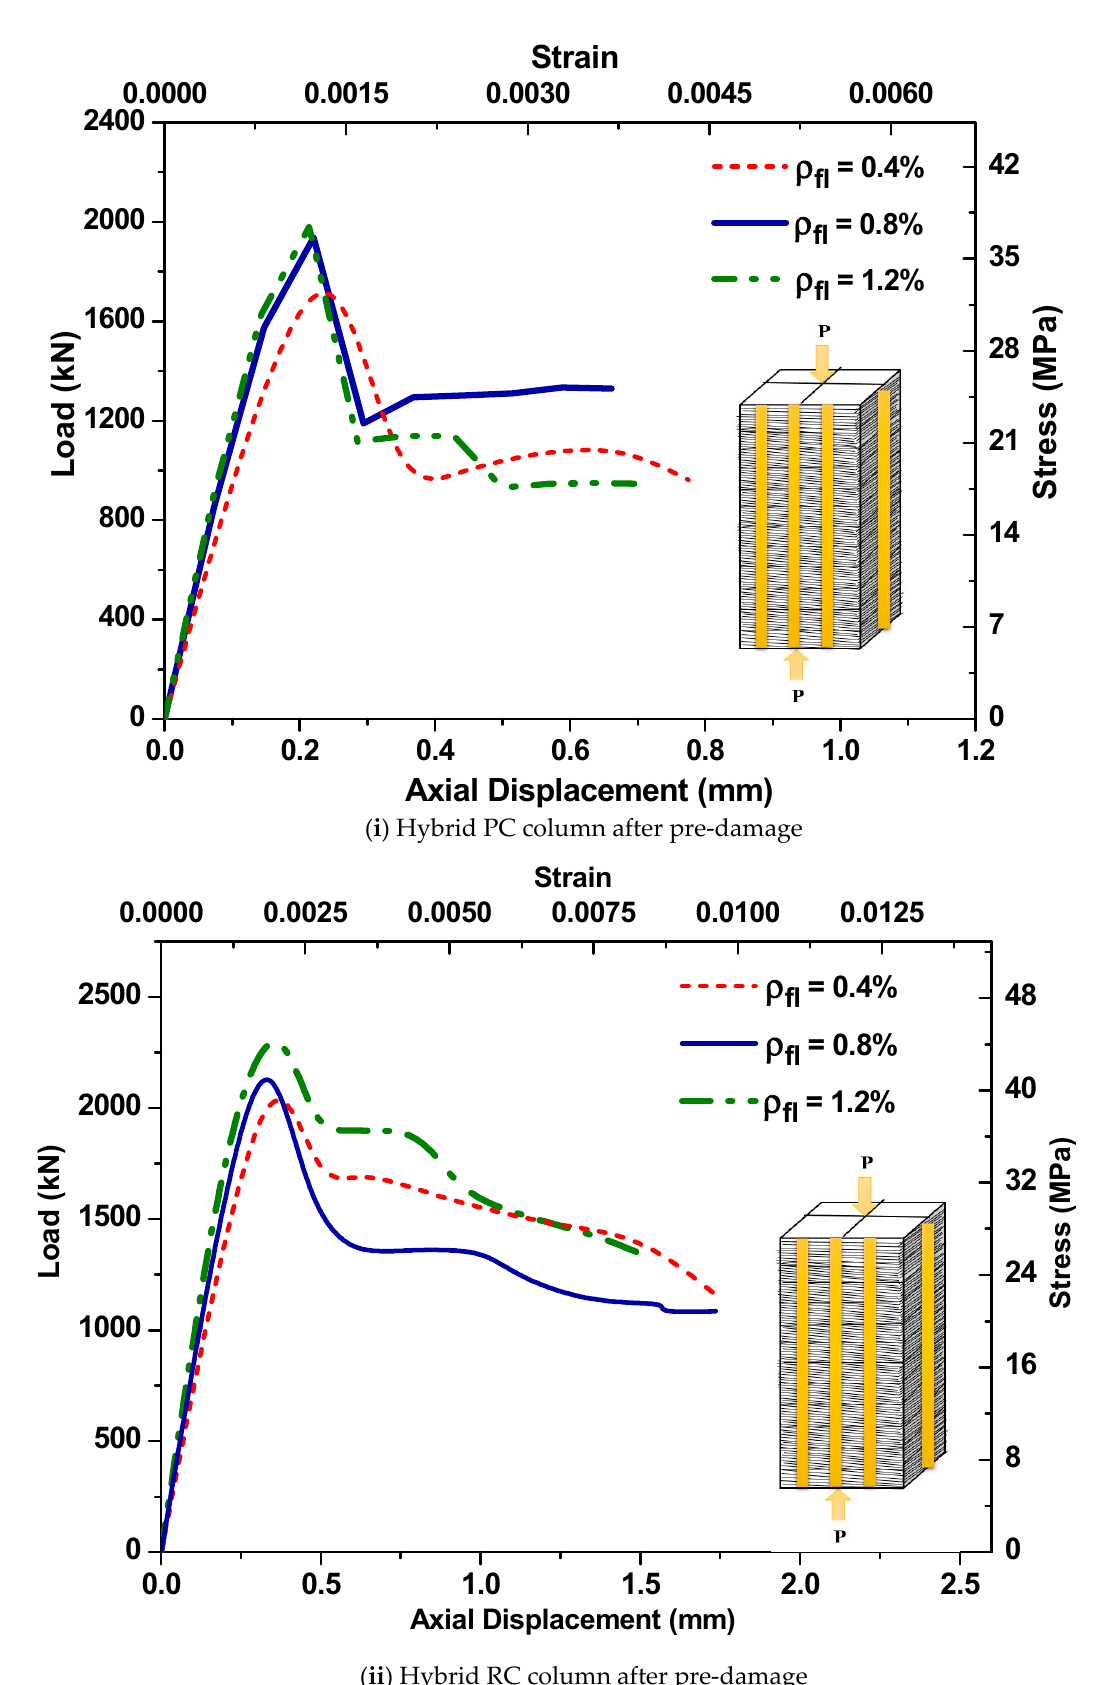
Figure 15. Effect of FRP reinforcement ratios on the hybrid strengthening of pre-damaged columns. Figure 15. E ff ect of FRP reinforcement ratios on the hybrid strengthening of pre-damaged